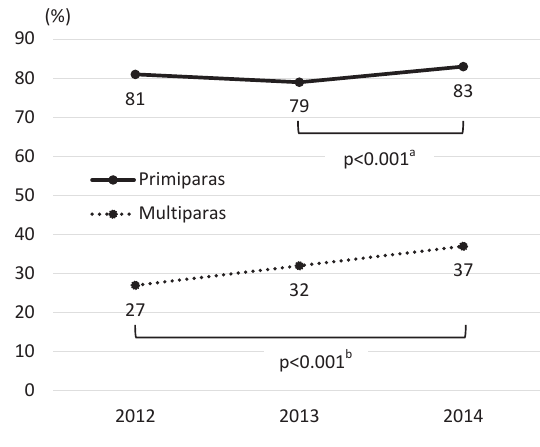
Figure 2. Respondents ’ pregnancy intention by parity. a Two-sample test of proportion was used to compare data for 2013 and 2014. b Nonparametric test for trend was used to compare data across the 3